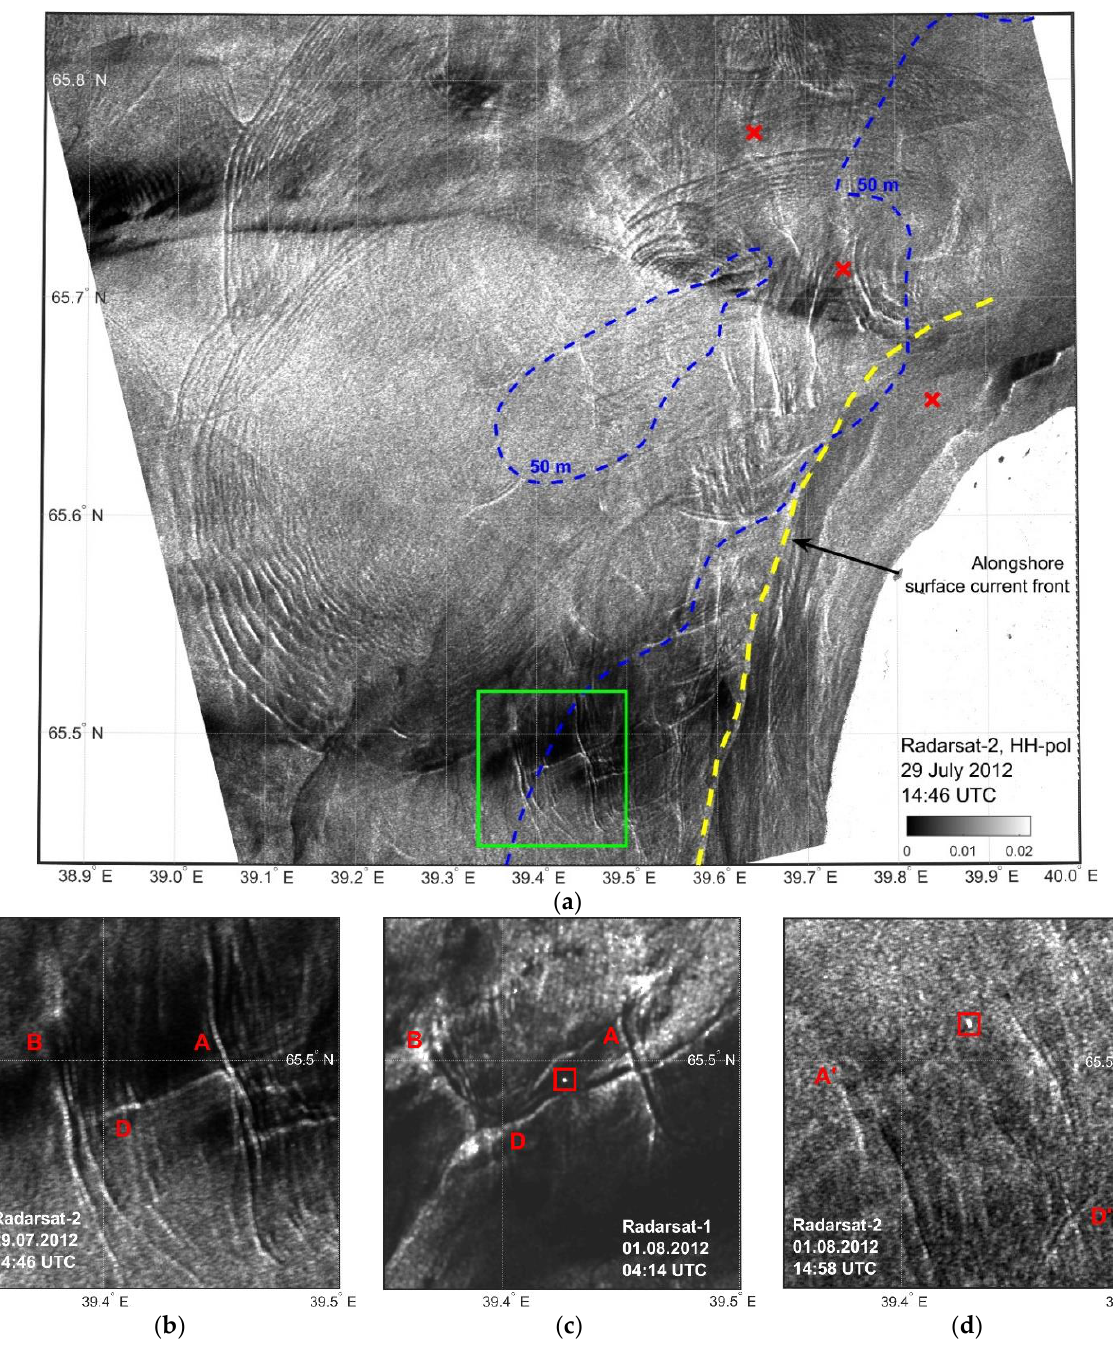
Figure 13. Examples of ISW manifestations in the southwestern part of the Gorlo Strait. ( a ) Radarsat-2 image acquired on 29 July 2012 at 14:46 UTC. Green box marks the location of an enlarged fragment shown in ( b ). Blue dashed line shows 50 m isobath. Yellow dashed line shows the location of the alongshore surface current front associated with the Dvina Front. Red crosses mark a station crossing the Gorlo Strait. ( b ) Enlarged fragment of ( a ) with marked locations of the ISW trains A, B, and D. ( c ) Enlarged fragment of a Radarsat-1 image acquired on 1 August 2012 at 04:14 UTC with marked locations of the ISW trains A, B, and D. Red square marks the ship location. ( d ) Enlarged fragment of Radarsat-2 image acquired on 1 August 2012 at 14:58 UTC with marked locations of the ISW trains A’ and D’. Red square marks the ship location.